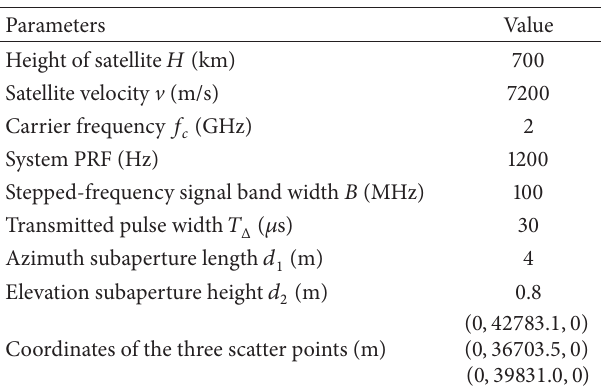
Table 2: Simulation